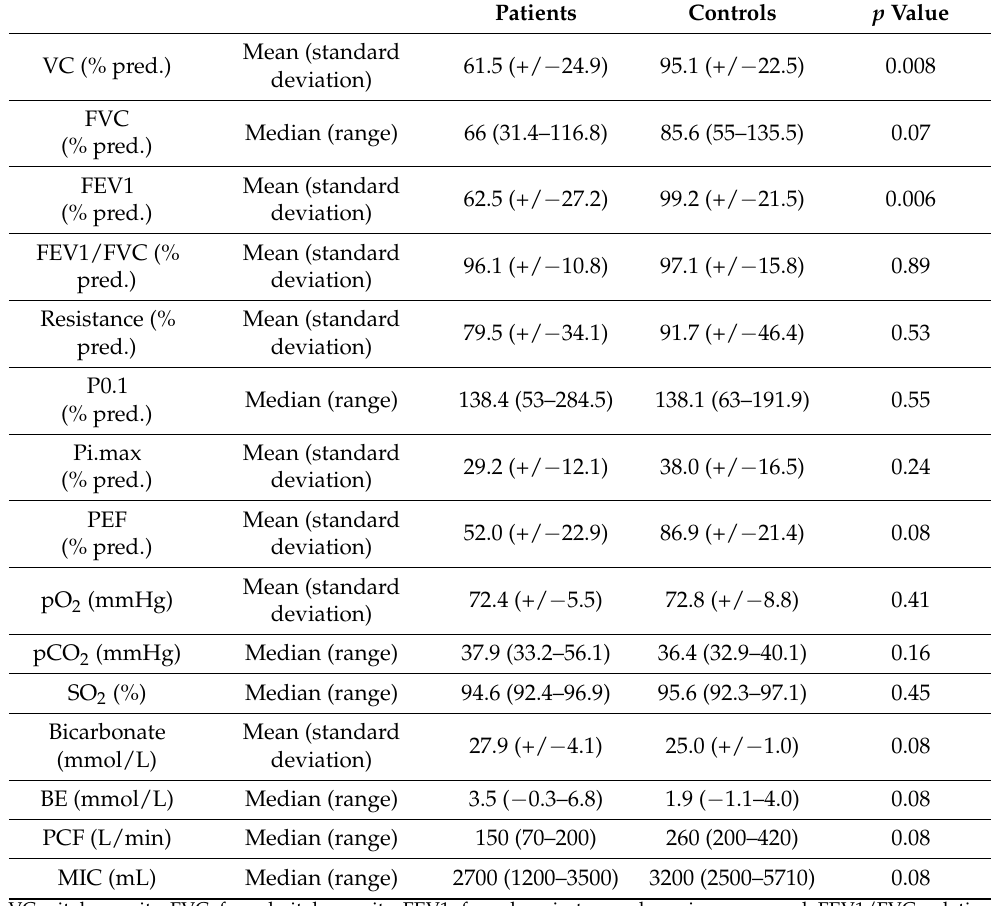
Table 3. Results from spirometry and cough